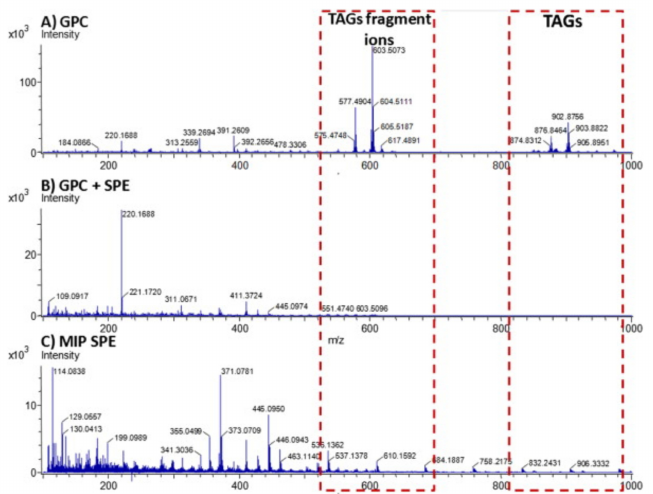
Figure 3. Direct analysis in real time-mass spectrometry (DART-MS) spectral fingerprints (positive ions) after ( A ) GPC-sample purified using GPC, ( B ) GPC + SPE-sample purified using GPC followed by purification using silica mini-column, and ( C ) MIP-SPE-sample extract purified using